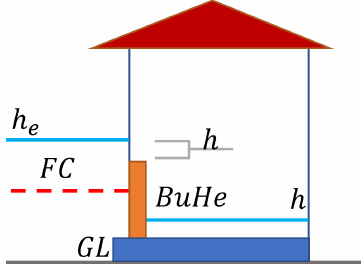
Figure 5. Visualization of bulkhead protection